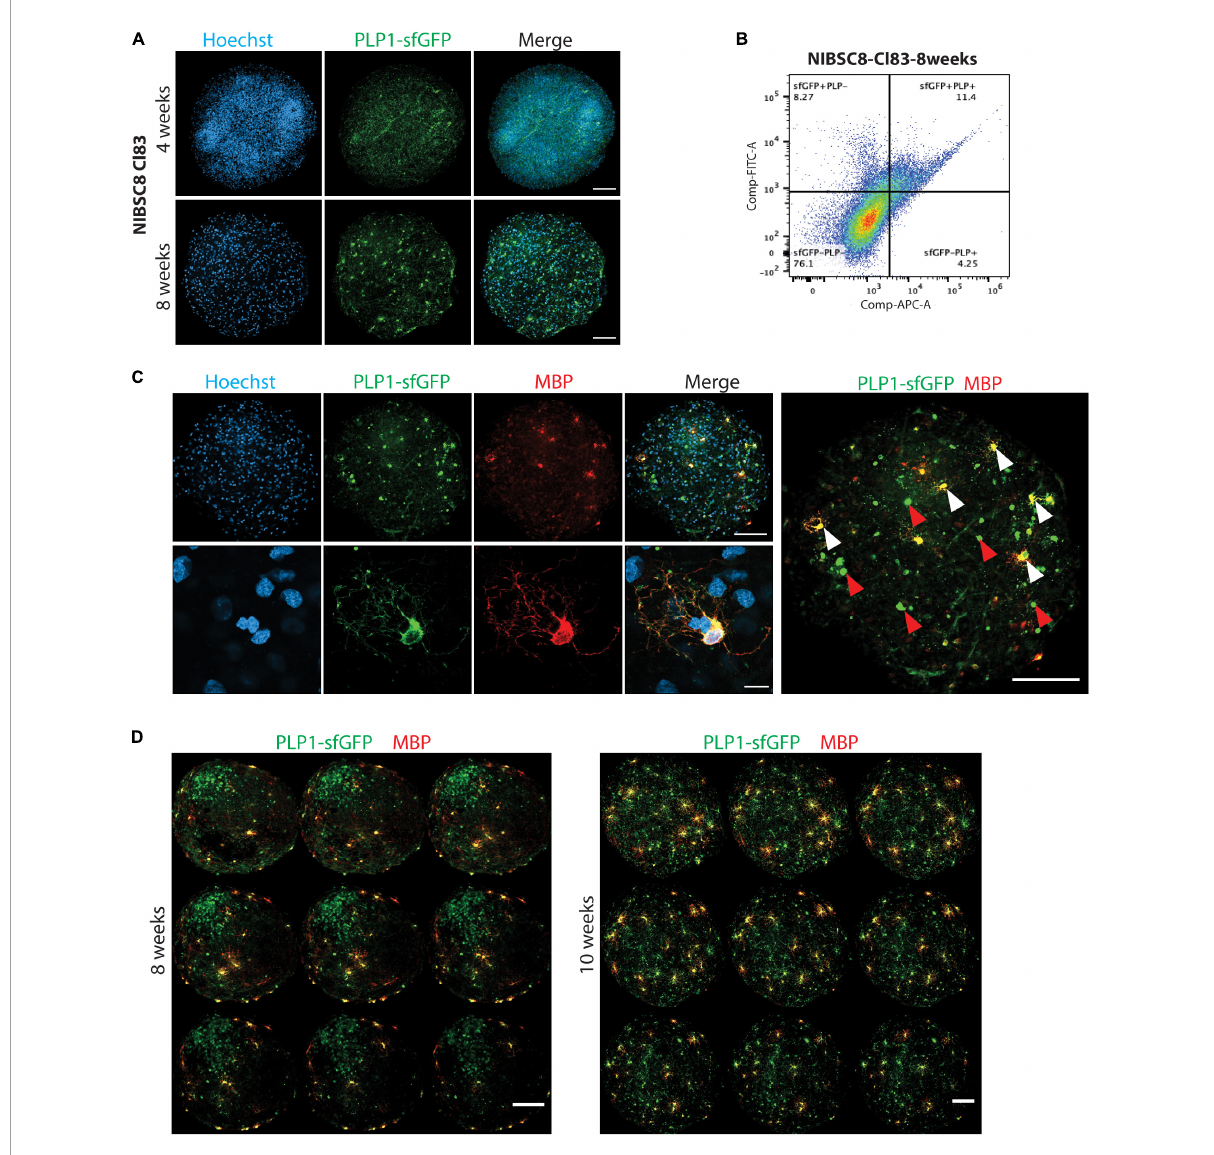
FIGURE4 sfGFP specific expression and intracellular co-localization with OLs in bMPS derived from NIBSC8-Cl83 hiPSCs. (A) Representative confocal images of 4- and 8-week-old bMPS showing the sfGFP+ cells (green) in the organoids. Different morphology was observed at 4 vs. 8 weeks. Nuclei are stained with Hoechst (blue, scale bar: 100 µ m). 5–8 bMPS were screened per week per experiment in three independent experiments. (B) A representative flow cytometry chart from three independent experiments shows co-localization of PLP1 (antibody labeling) and sfGFP (endogenous) in 8-week-old bMPS. Gates for both conditions were set up based on corresponding single color/unstained controls separately for each condition ( Supplementary Figure 7F ). (C) Representative confocal images of 8-week-old bMPS showing PLP1-sfGFP (green) and MBP (red) expression in OLs. White arrowheads show mature OLs (sfGFP+/MBP+) and red arrowheads show immature OLs (GFP+/MBP-; scale bar: upper panel 100 µ m; lower panel 10 µ m). Nuclei are stained with Hoechst (blue). 5–8 bMPS were screened per experiment in three independent experiments (D) Representative montage of z-stack imaging in 8- and 10-week-old bMPS showing immature OLs (GFP+MBP-) and OLs (sfGFP+ MBP+) migration and maturation (scale bar: 100 µ m). 5–8 bMPS were screened per week per experiment in three independent